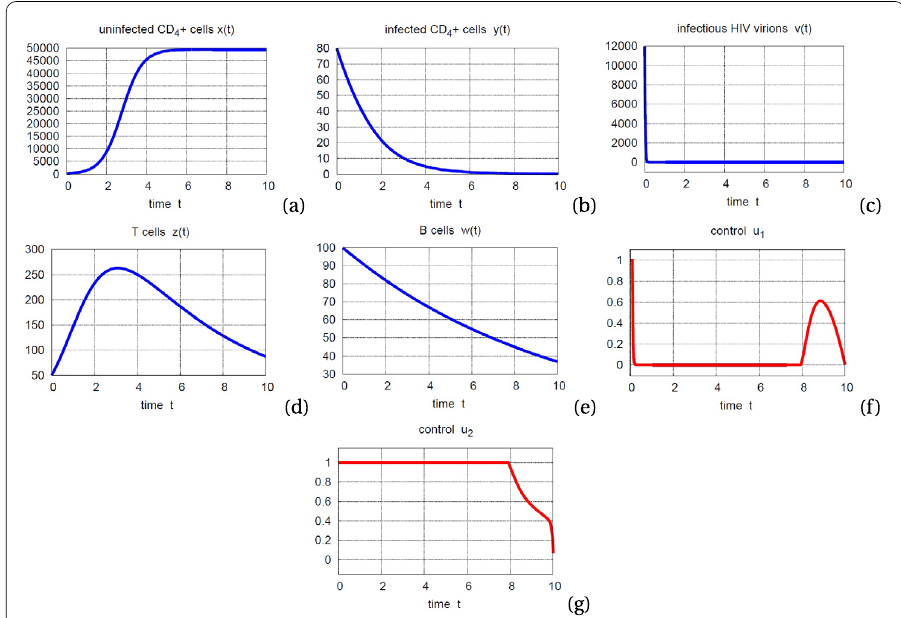
Figure 3 ( a ) Saturation level of uninfected CD + 4 T-cells with optimal control for Column 5 of Table 2 ( b ) Level of infected CD + 4 T-cells with optimal control for Column 5 of Table 2 ( c ) level of viral load with optimal control for Column 5 of Table 2 ( d ) level of T-cells with optimal control for Column 5 of Table 2 ( e ) level of B-cells with optimal control for Column 5 of Table 2 ( f ) Behavior of optimal control, u ∗ 1 as protease inhibitor for Column 5 of Table 2 ( g ) Behavior of optimal control, u ∗ 2 as reverse transcriptase inhibitor for Column 5 of Table 2